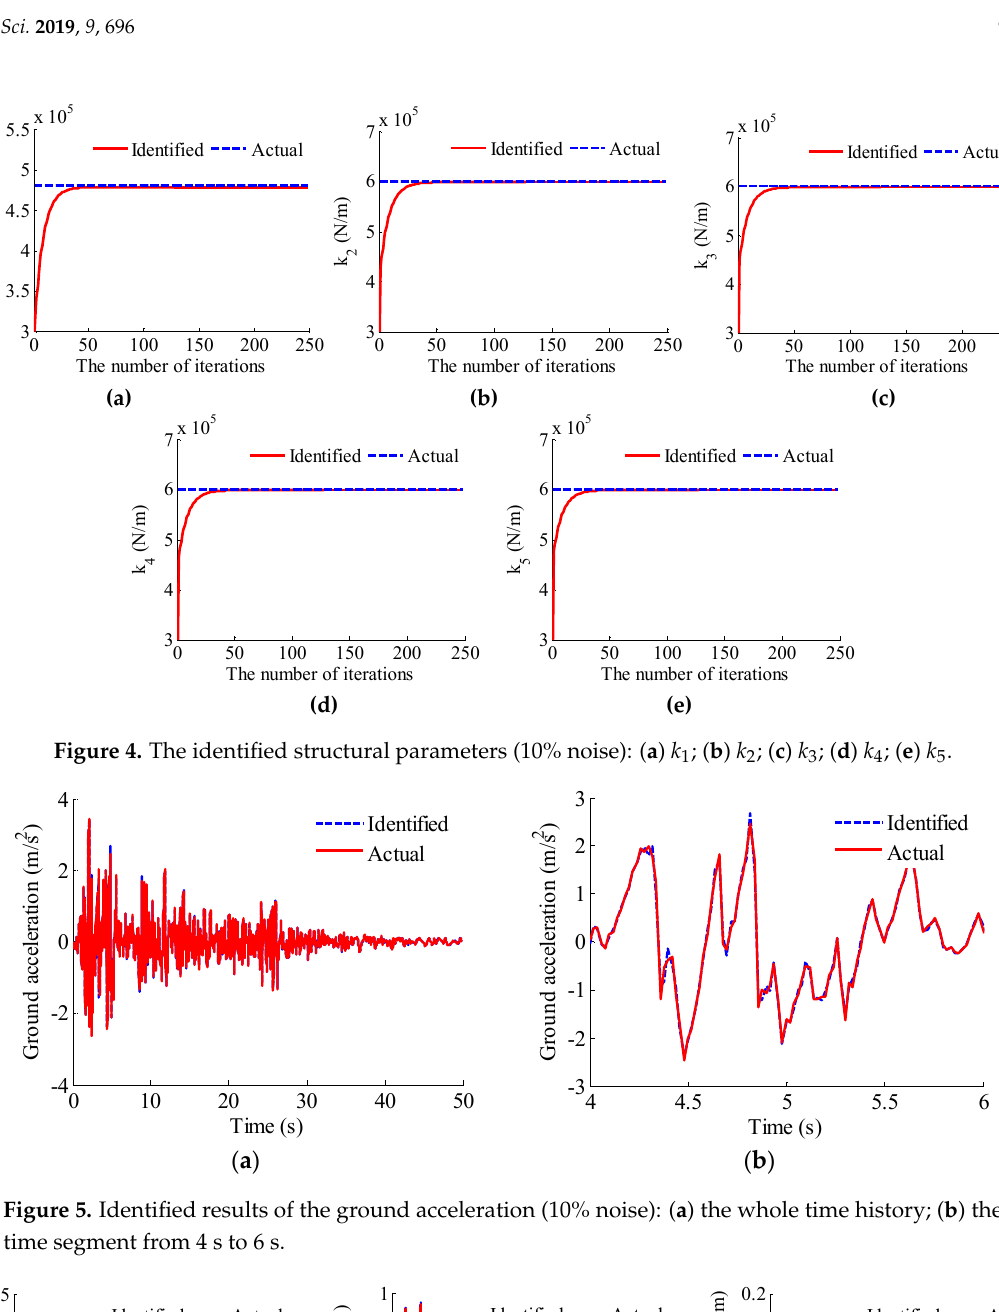
Figure 3. Comparison of the effect of noise intensity on the iteration process: ( a ) noise-free; ( b ) 5% noise; ( c ) 10% noise.